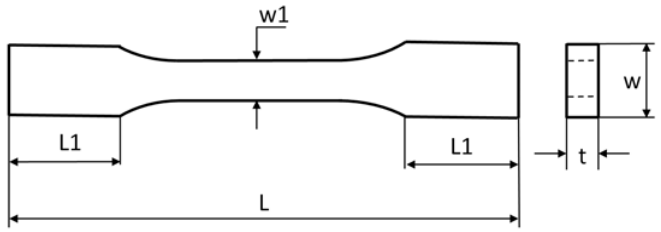
Figure 6. Dimensions of sample subjected to tests.